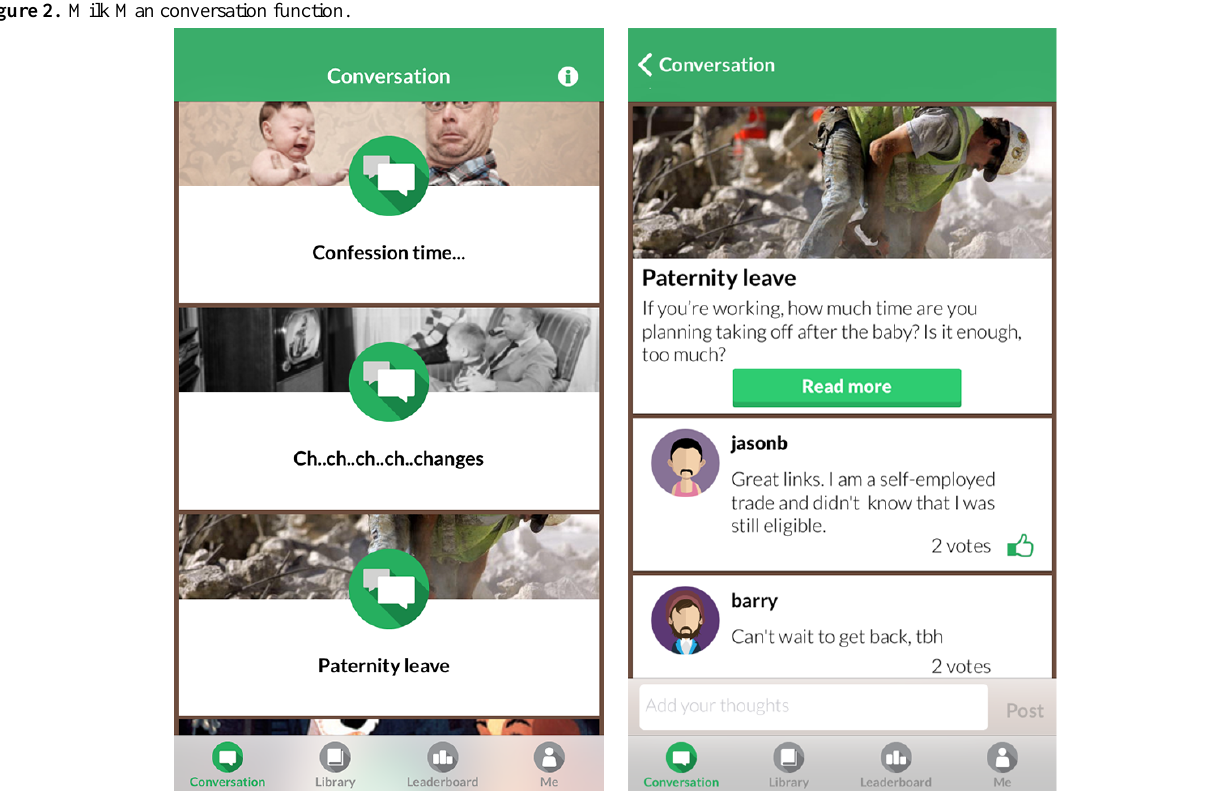
Figure 2. Milk Man conversation